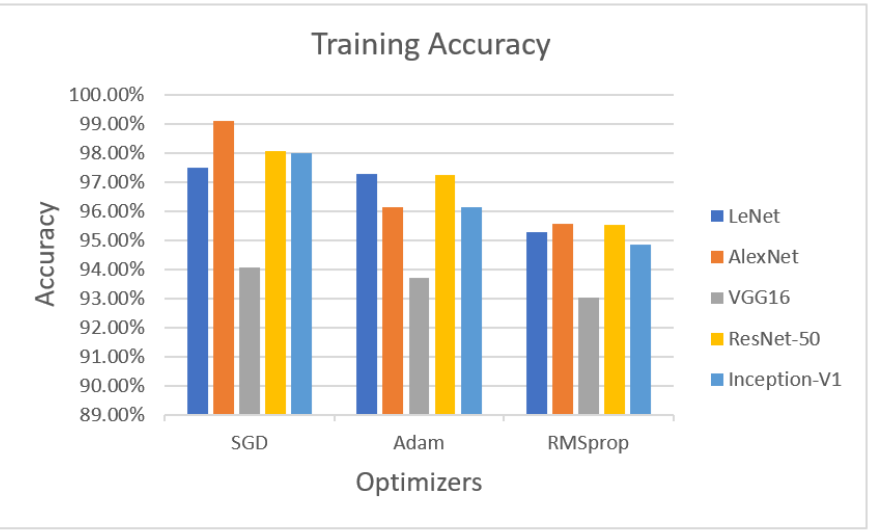
Figure 2. Performance evaluation with statistical parameters for LeNet, AlexNet, VGG16, ResNet-50, and Inception-V1 (training accuracy).